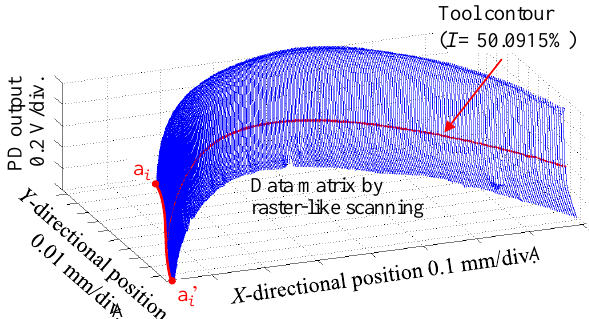
Figure 12. Matrix data of the PD output acquired at each line scan.